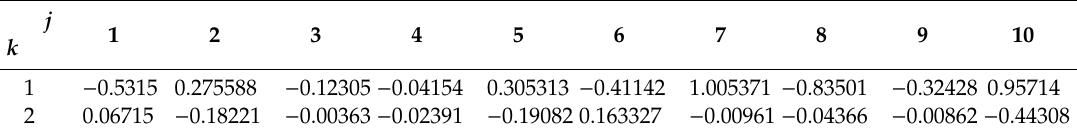
Table 6. Weights W jk from the j th hidden layer to k th output